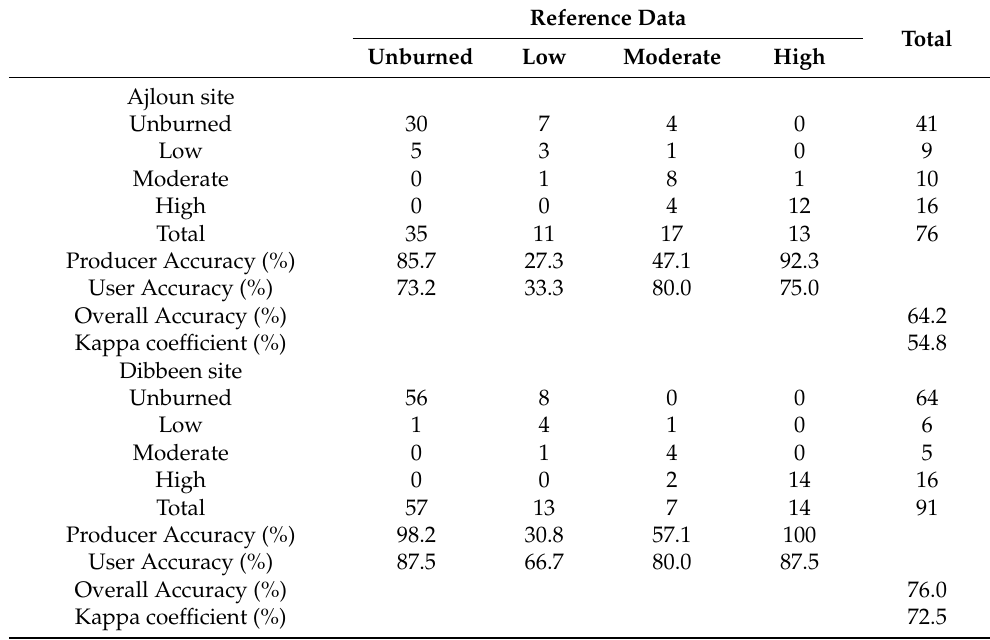
Table 4. Confusion matrix and accuracy assessment of burn severity levels derived using Sentinel-2 differenced Normalized Burn Ratio (dNBR), for Ajloun (2020) and Dibbeen (2016)